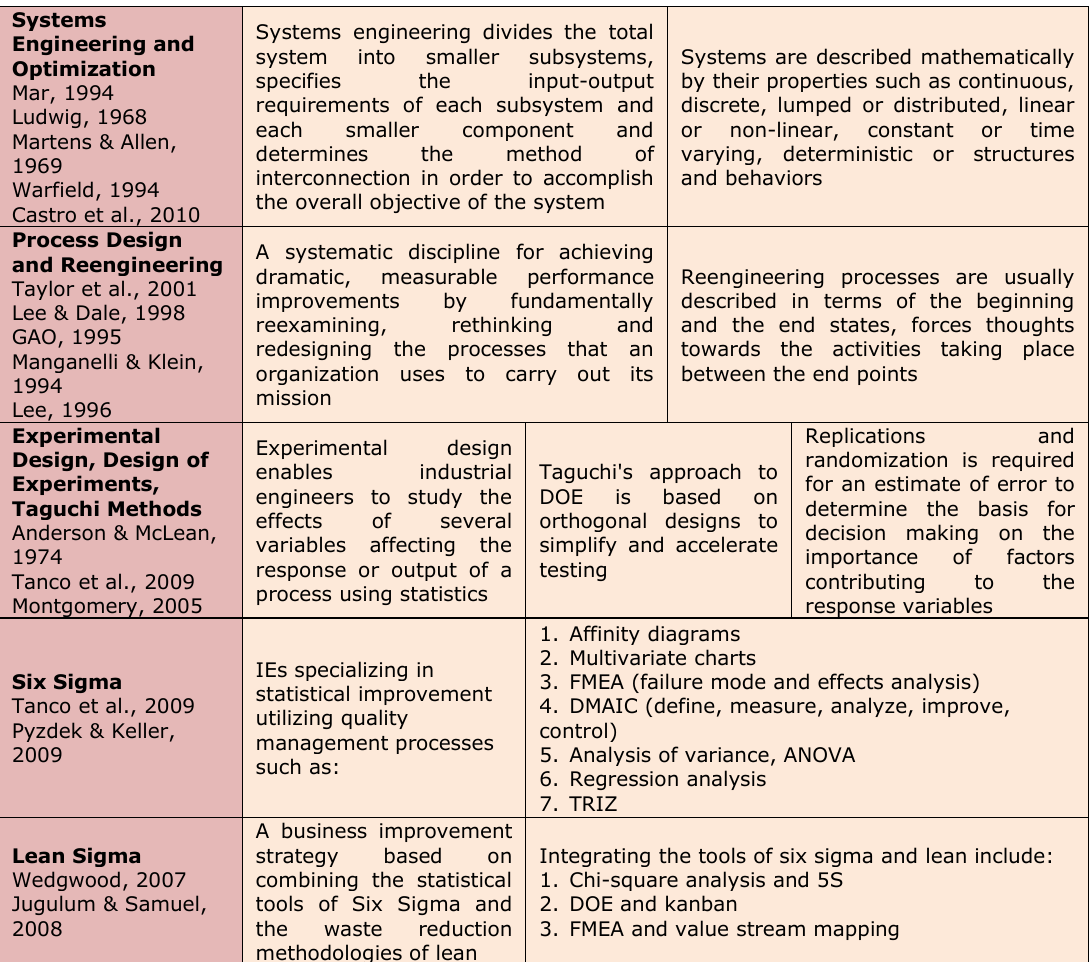
Table 2. Skill sets of industrial engineers in the 21st